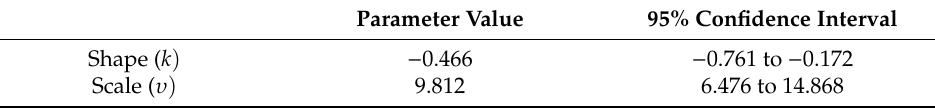
Table 4. Parameter values for the generalized Pareto distribution corresponding to the